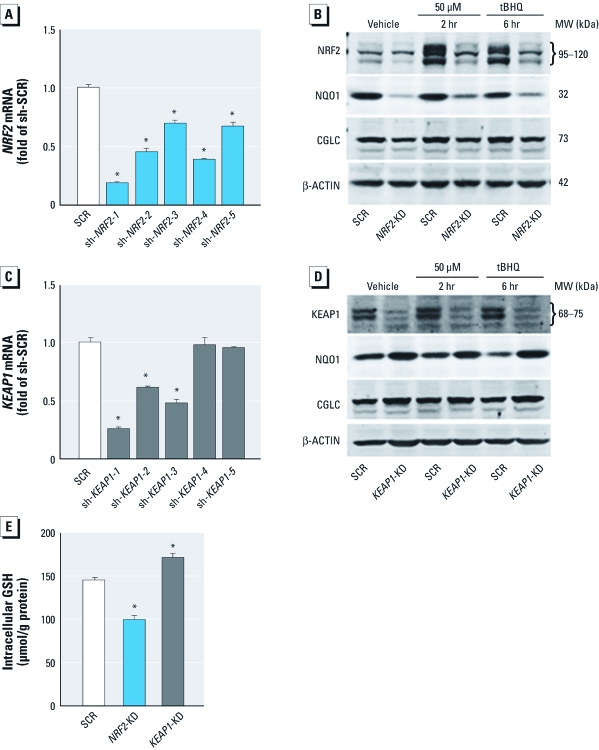
Stable knockdown of NRF2 and KEAP1 by lentiviral shRNAs in HaCaT cells. (A and C) Silencing effect of NRF2 (A) and KEAP1 (C) in HaCaT cells transduced with shRNA lentivirus targeted against human NRF2, KEAP1, or scrambled (SCR) nontarget negative control (sh-SCR) (n = 3). sh-NRF2-1 through sh‑NRF2-5 indicate shRNAs targeting NRF2; sh-KEAP1-1 through sh-KEAP1-5, shRNAs targeting KEAP1. (B and D) Protein expression of NRF2 (B), KEAP1 (D), and NRF2 target genes NQO1 and GCLC in NRF2-KD and KEAP1-KD cells. Cells were treated with 50 μM tBHQ for the indicated time, and whole-cell lysates were separated on 4–12% Tris-glycine gels. β-ACTIN was used as loading control. (E) Intracellular GSH content in NRF2-KD and KEAP1-KD cells (n = 6). *p < 0.05 versus SCR (A, C, E).